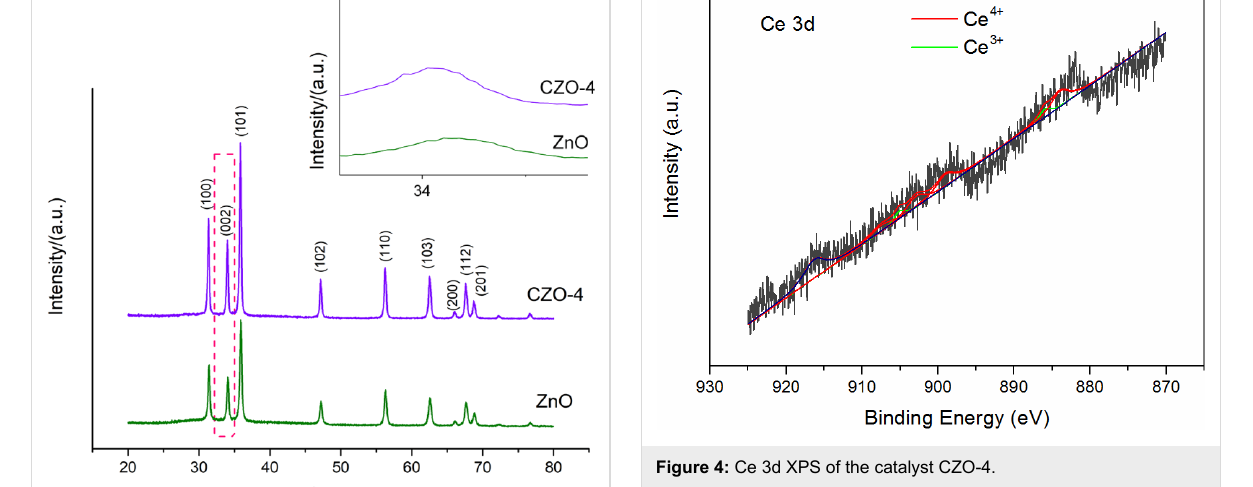
corresponding to the (100), (002), (101), (102), (110), (103), (200), (112) and (201) crystal planes. These observations are consistent to those of wurtzite hexagonal ZnO (JCPDS No.